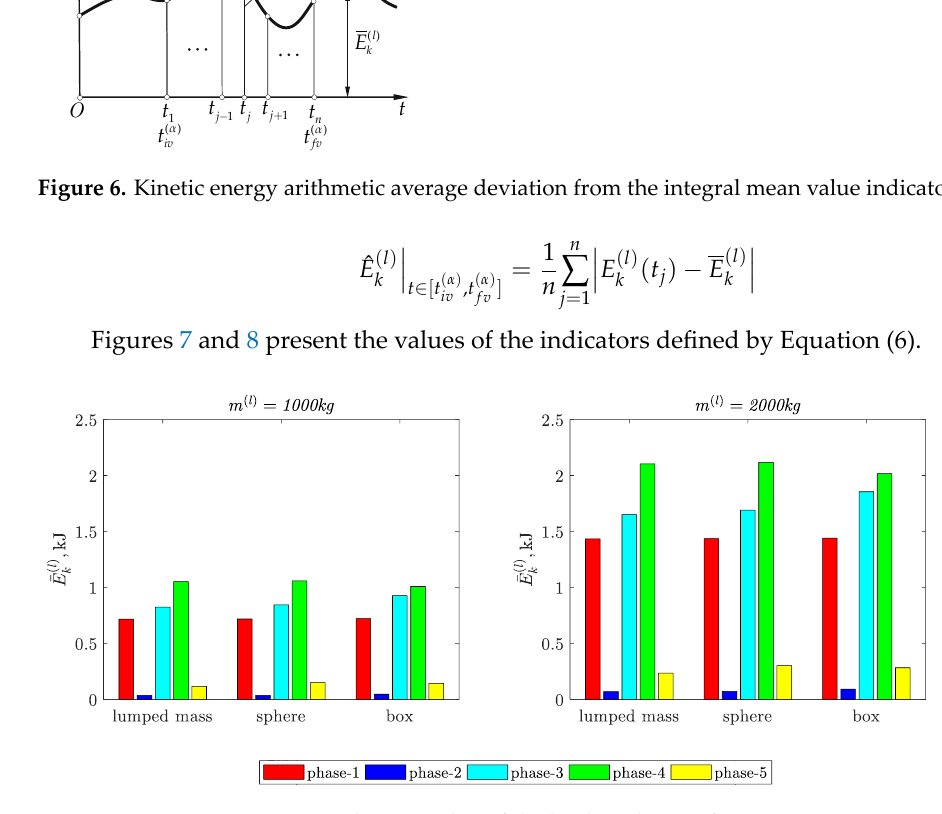
Figure 7. Kinetic energy integral mean value of the load in phases of input movement.